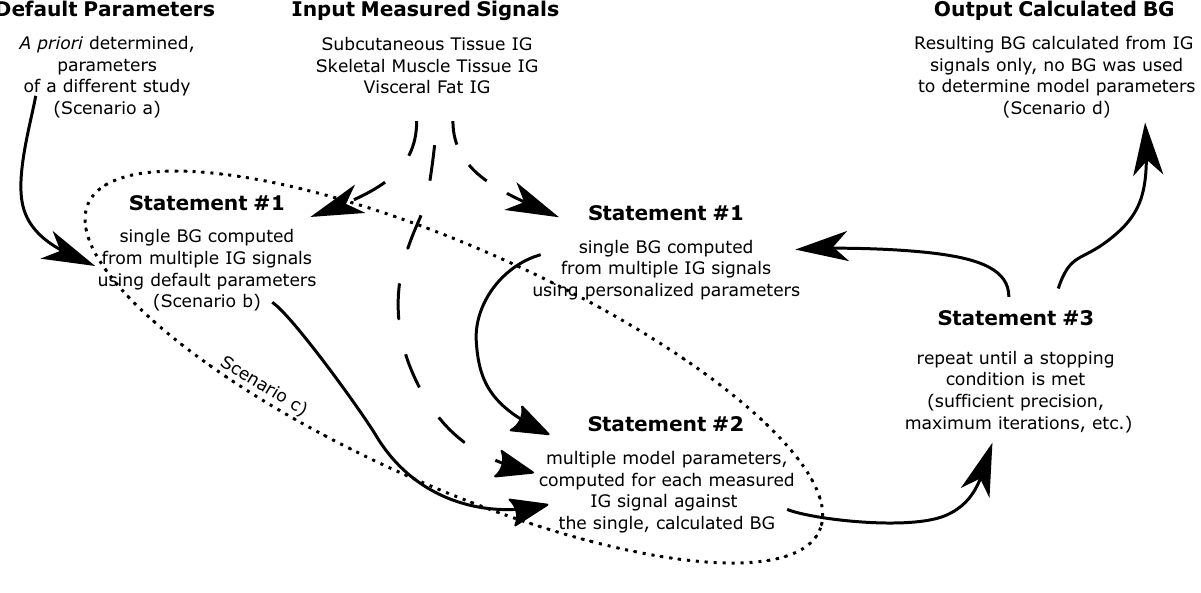
Figure 1. Calculation flow of the proposed method with depicted